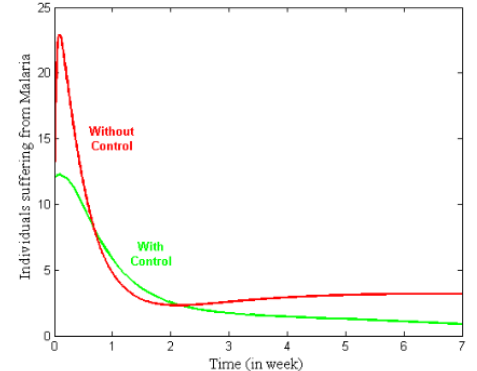
Figure 6. Impact of